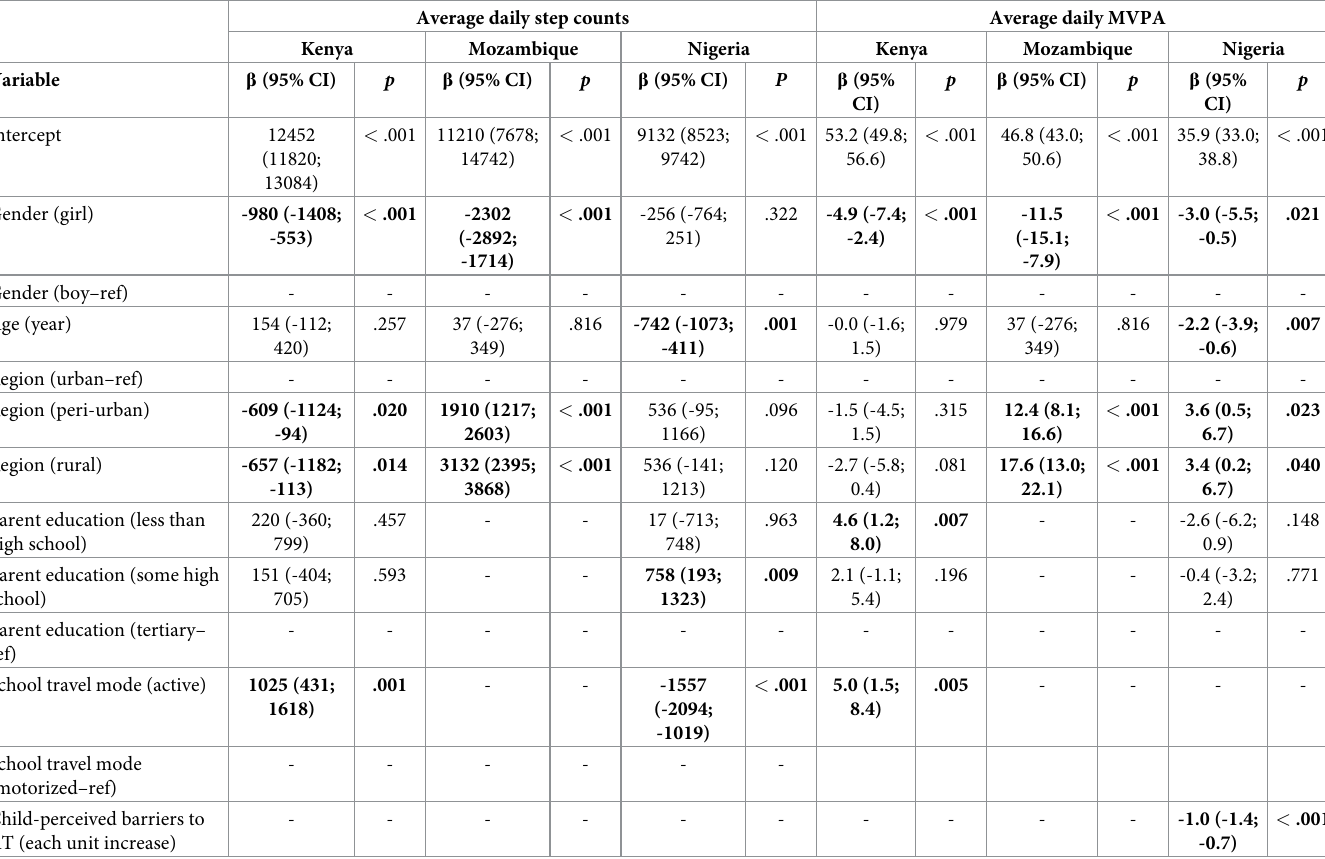
Table 6. Correlates of average daily step counts and average daily MVPA stratified by country in multi-variable